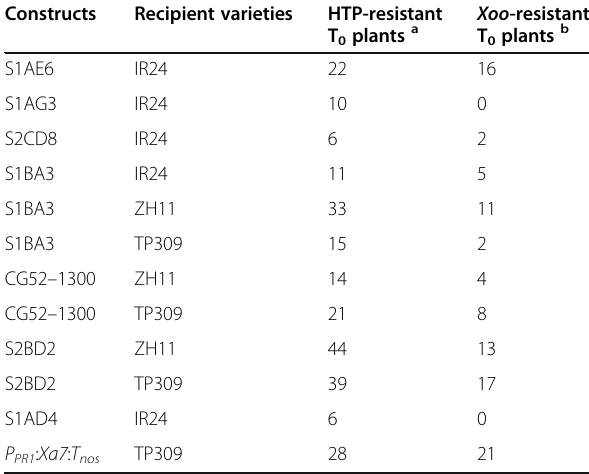
Table 1 Complementary Transgenic Plants Generated in